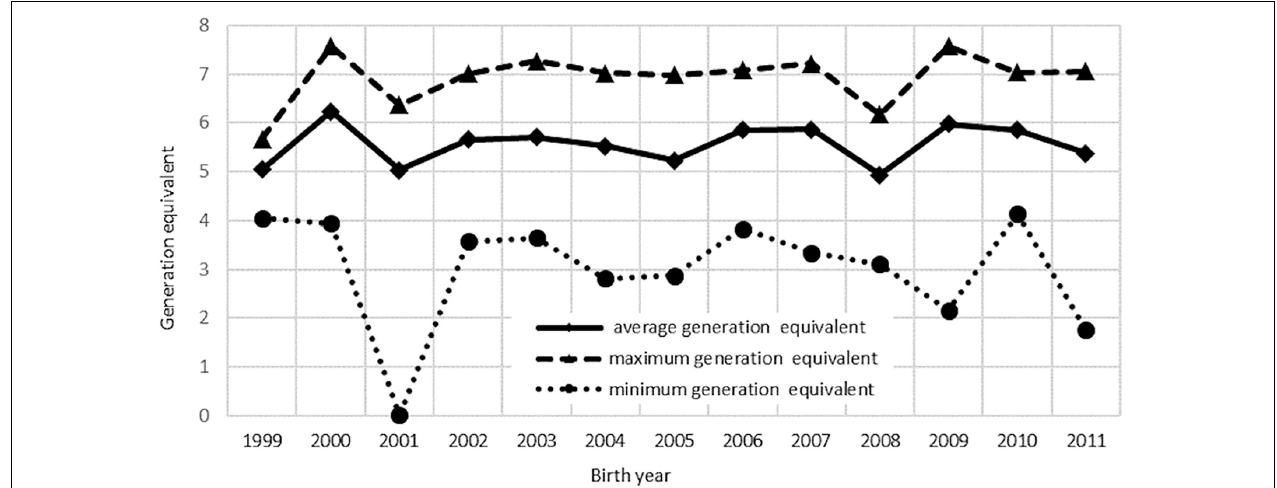
FIGURE 2 | Average, minimum, and maximum of discrete generation equivalents of the studied population.